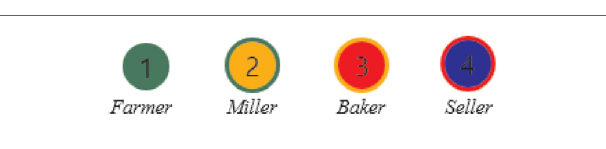
FigUre 10 | representation of agent types in Maser